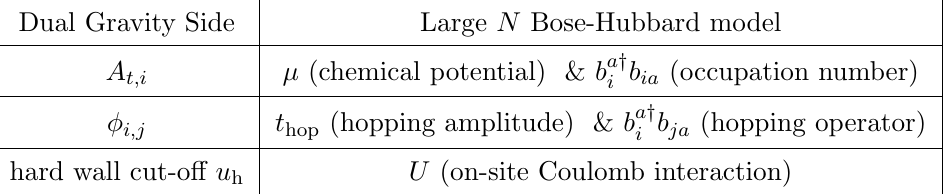
table 1. It consists of n U(1) gauge (cid:12)elds A (cid:22);i , one on each lattice site, and bi-fundamental